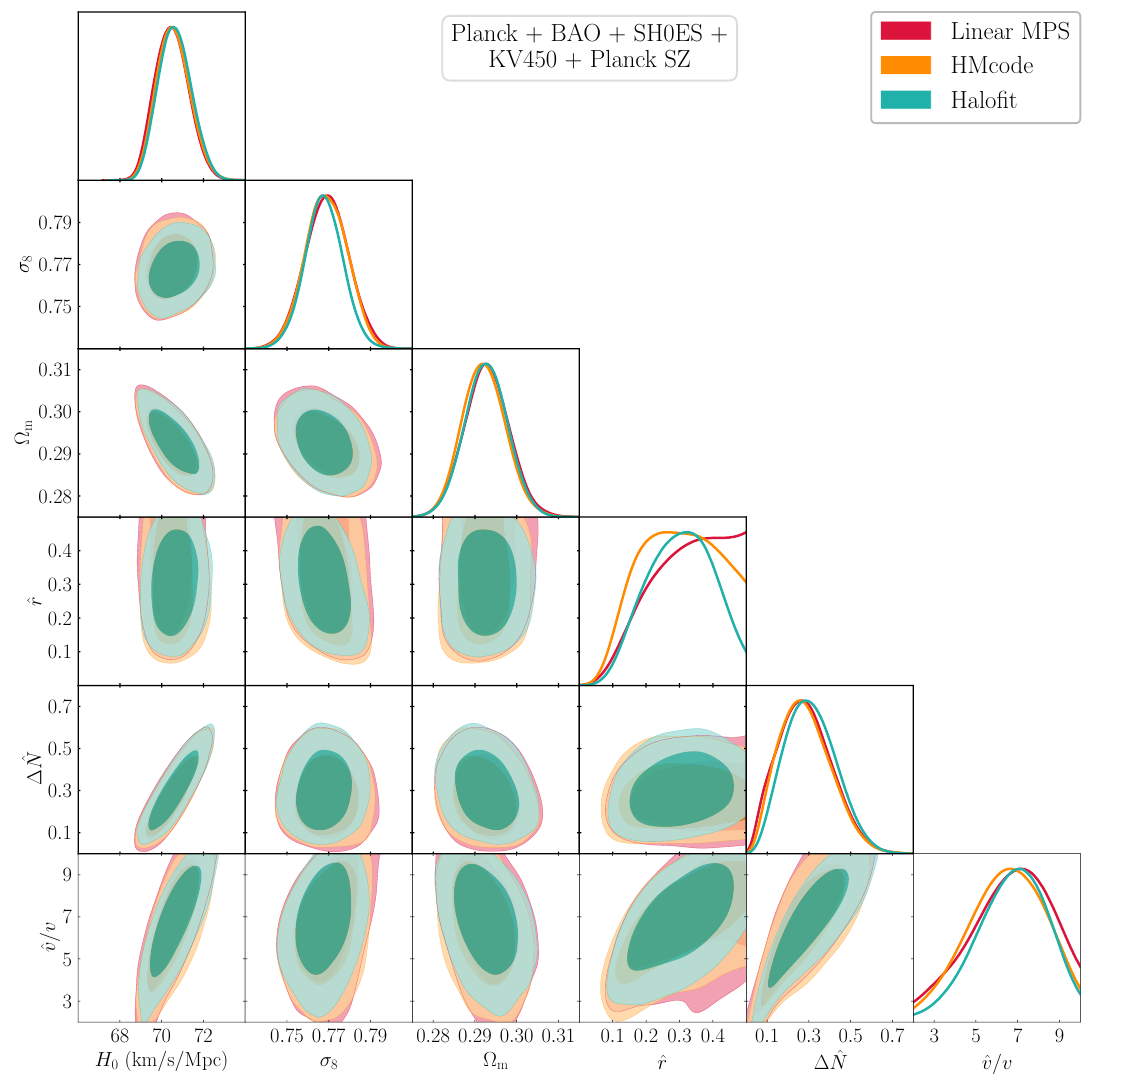
Figure 19. Same plots as in figure 15 but with two different non-linear corrections to the matter power spectrum. Since non-linear corrections for the MTH model using Halofit or HMcode becomes less reliable for large ˆ r , we use an upper limit of 0.5 on ˆ r to obtain this plot. For the VEV, we use a flat prior of ˆ v/v ∈ [2 , 10]